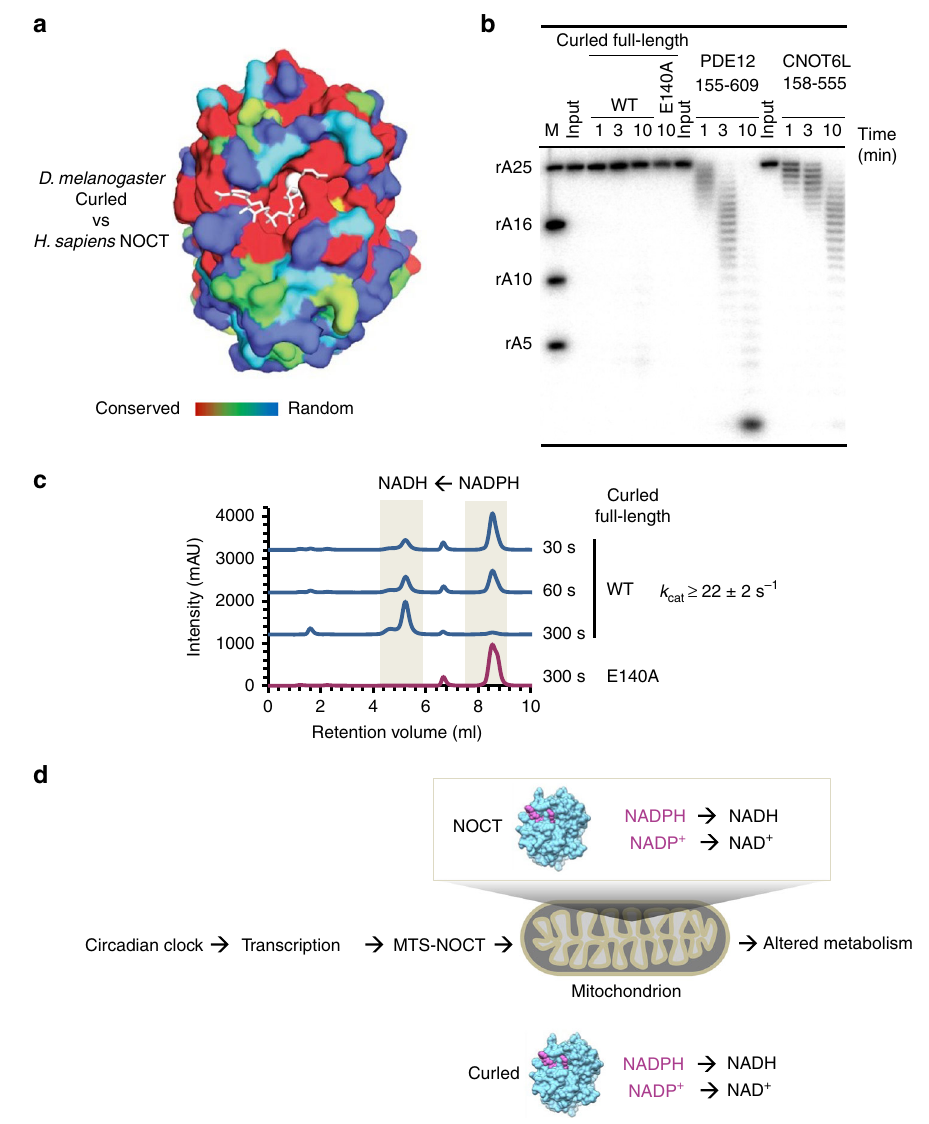
Fig. 5 Biochemical characterization of Curled. a Structure of human NOCT colored by sequence conservation between fruit fl y and human proteins. Color scale shows a range from invariable (red) to random (blue). b 32 P-poly-A RNA cleavage assays using D. melanogaster Curled, Curled E140A active site mutant, and human deadenylases CNOT6L and PDE12 (2 μ M each). Faint bands at 10 min in WT Curled arise from a minor contaminating endonuclease. The E140A mutant corresponds to the E195A mutation in human NOCT (Figs. 2a and 4e). c IEC trace for cleavage of NADPH (1 mM) by Curled from Drosophila Melanogaster (500 nM). The catalytic constant was calculated as k obs (cid:129) S 0 /E 0 from ( c ) and Supplementary Fig. 5b. This value represents the lower estimate for k cat . d The proposed model for NOCT integration in the circadian system based on the results of our work. Source data are provided as a Source Data fi